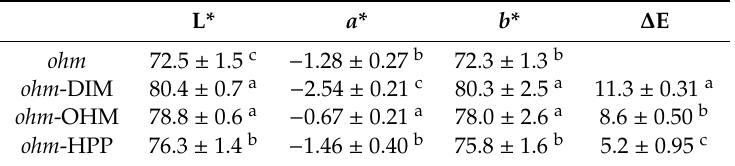
Table 2. Colorimetric parameters of peach